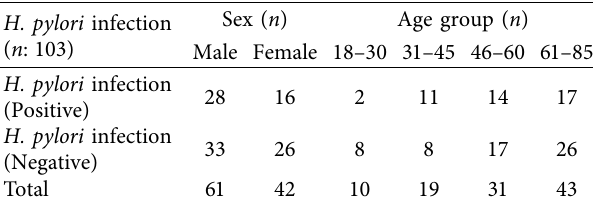
Table 5: Demographic characteristics of patients with H. pylori